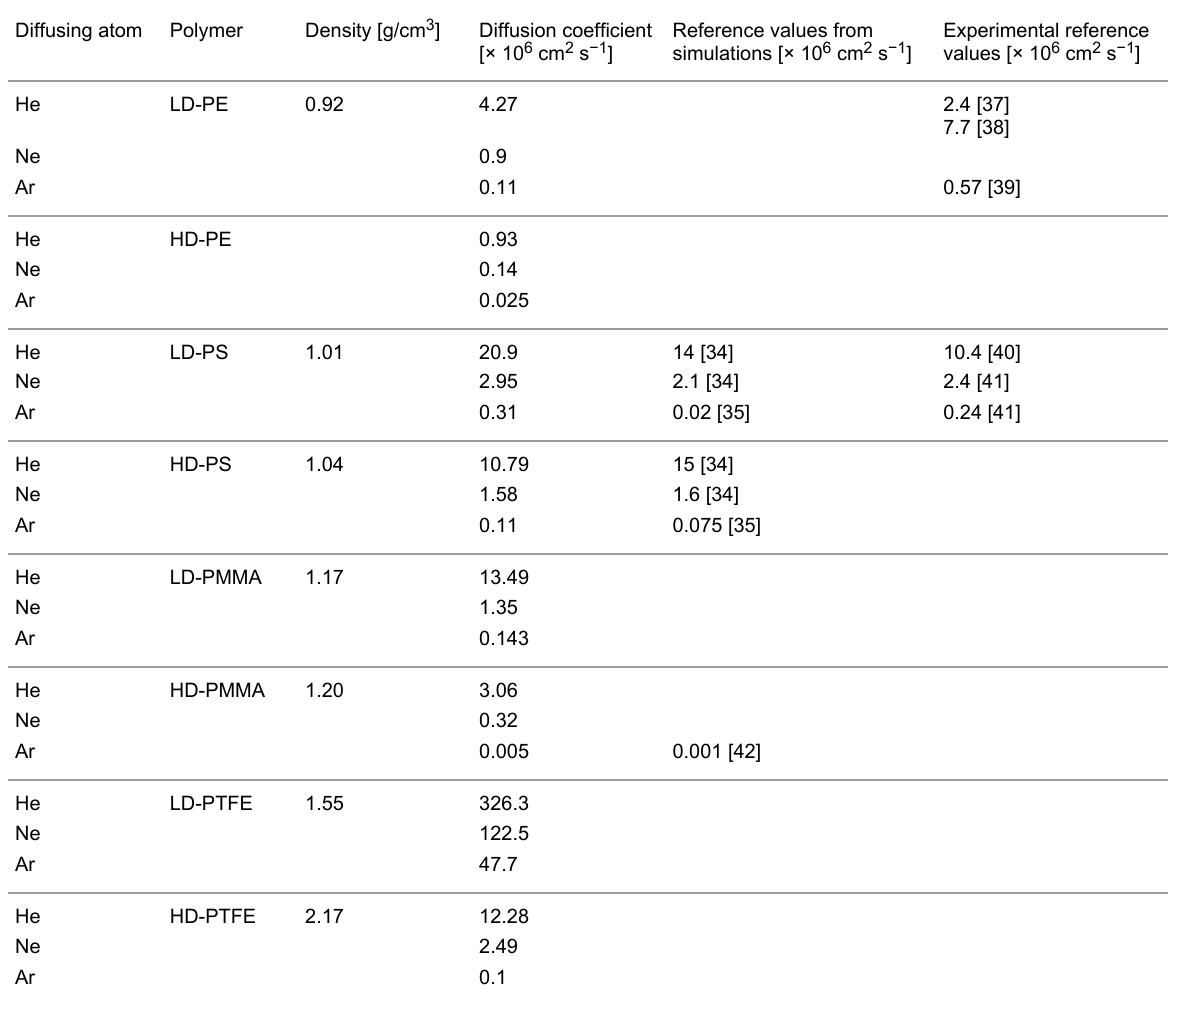
Table 1: Summary of the diffusion coefficients (× 10 6 cm 2 s − 1 ) of He, Ne and Ar in PE, PS, PMMA and PTFE calculated in this work with comparison to experimental and other simulation studies. Diffusing